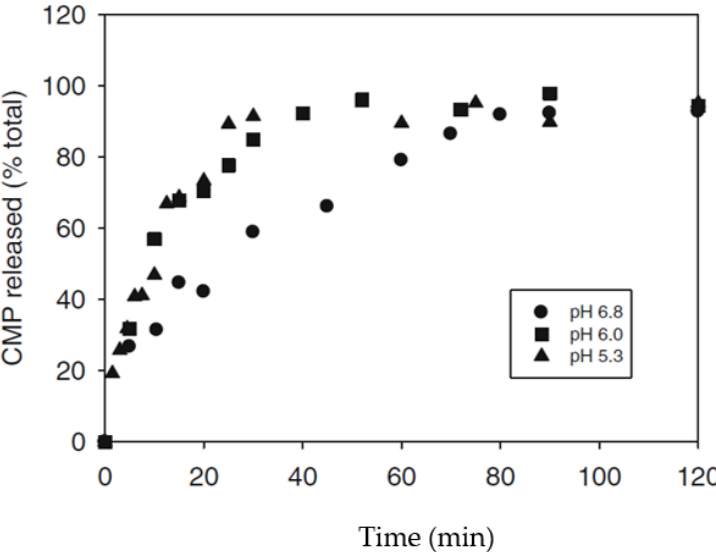
Figure 4. Release of casein macropeptide during coagulation of milk at different pH values. Repro- duced with permission from [Corredig, M.; Salvatore, E.], [Enzymatic Coagulation of Milk. Advanced Dairy Chemistry: Volume 1B: Proteins: Applied Aspects]; published by [Springer],